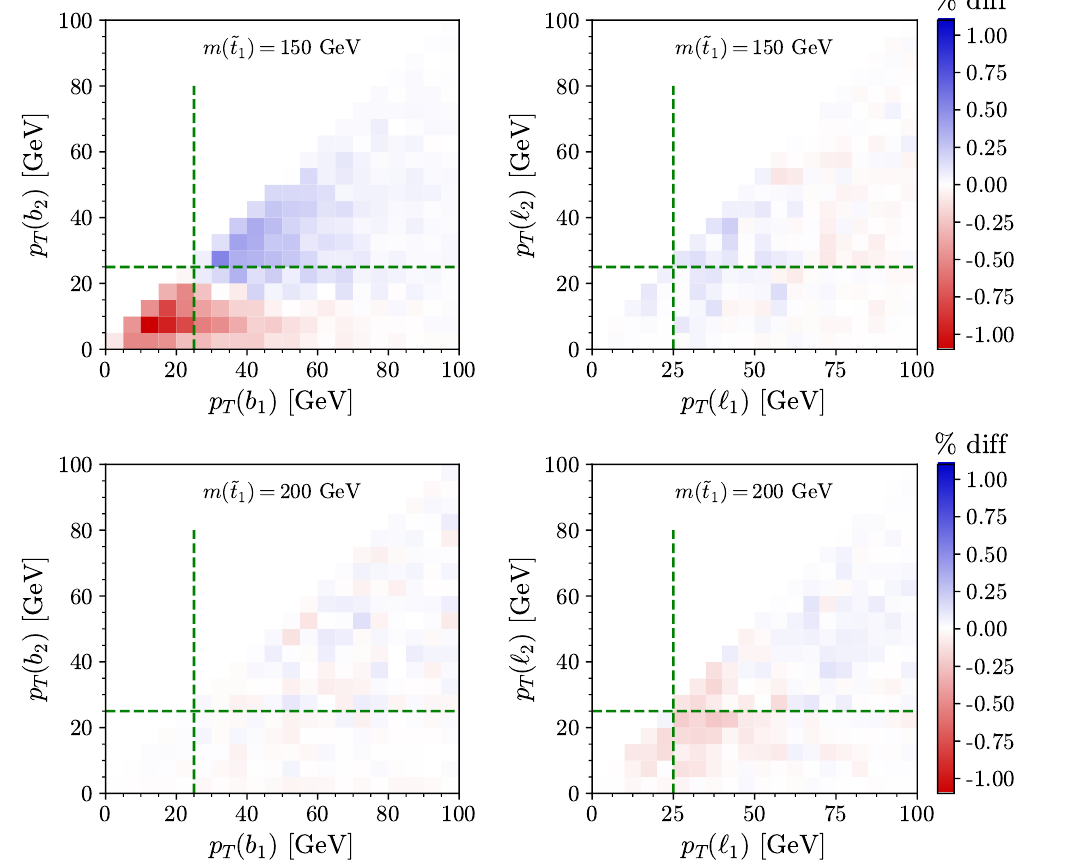
0 MG ) = 1 GeV; see the caption of NWA - Full for m (~ (cid:31) 1